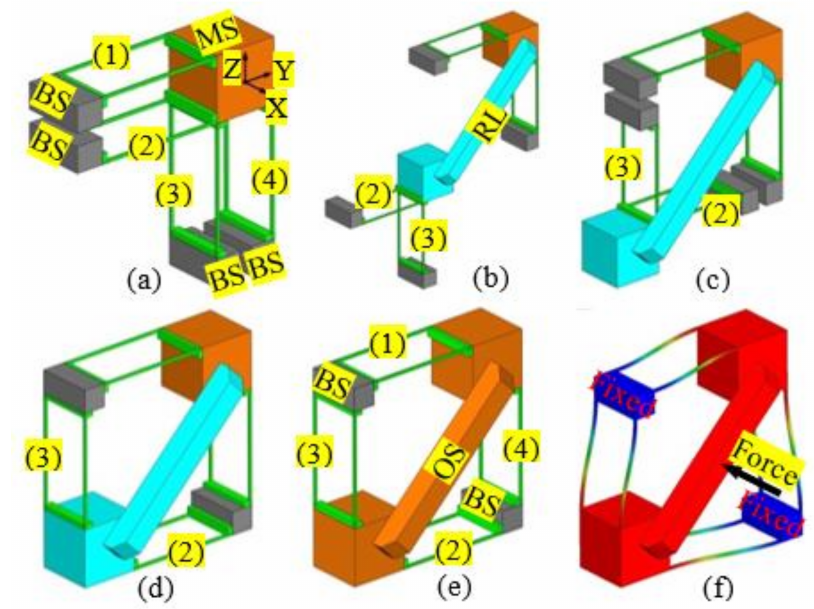
Figure 2. Position-space-based reconfiguration for generating a 1-DOF symmetric translational compliant mechanism: ( a ) decomposition of the 1-DOF translational compliant mechanism; ( b ) translations of compliant modules; ( c ) rotations of compliant modules; ( d ) further translations of compliant modules; ( e ) symmetric 1-DOF translational compliant mechanism; and ( f ) deformation of the 1-DOF translational compliant mechanism under an actuation